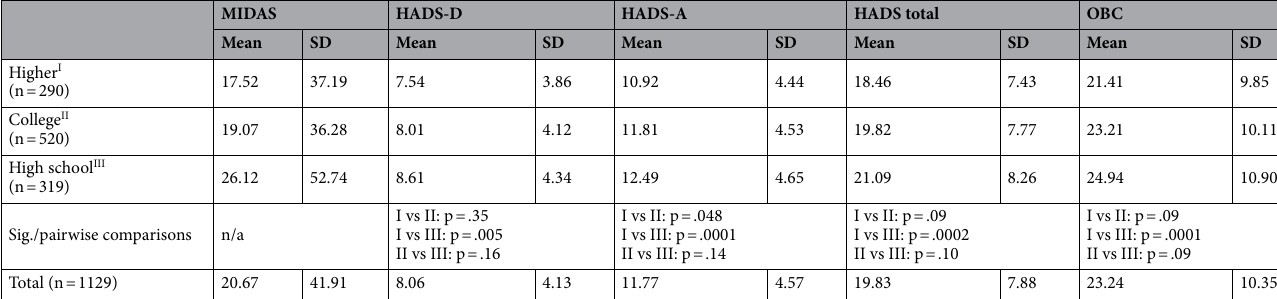
Table 4. Mean scores for the MIDAS, HADS-D, HADS-A, HADS total and OBC in different education level groups (SD – standard deviation). SD—standard deviation, MIDAS—Migraine Disability Assessment, HADS—Hospital Anxiety and Depression Scale, OBC—Oral Behaviors Checklist, sig.— p value for the statistical significance of the analyzed differences, n/a—not applicable since the analysis indicated no statistically significant differences (see main text for details).